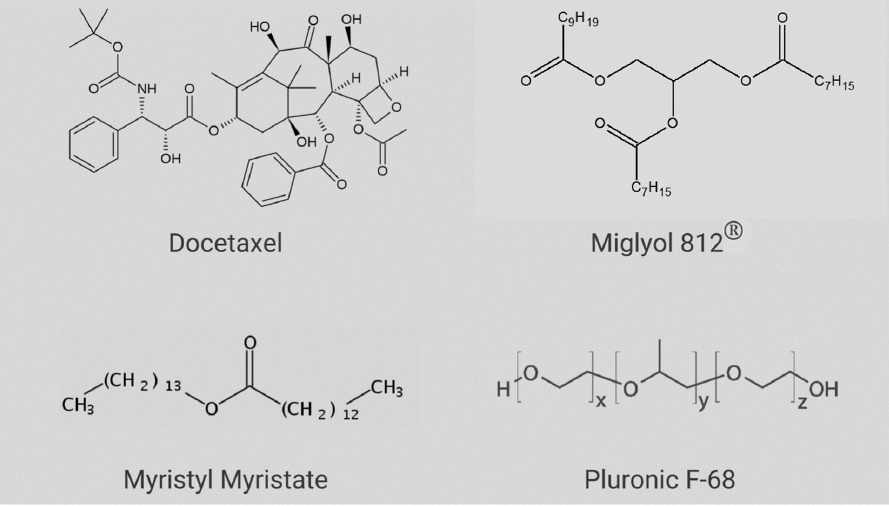
Figure 1. Chemical structures of the compounds used in NLC preparation and